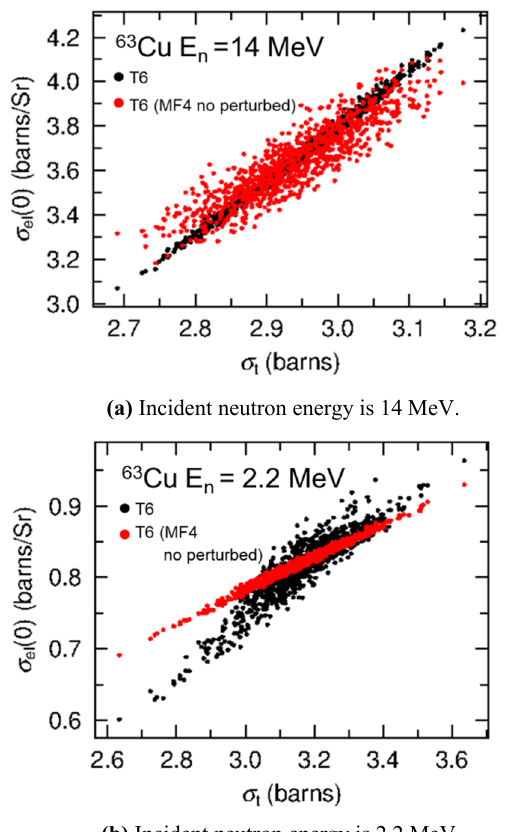
Fig. 11. Correlation between 63 Cu total cross section and elastic scattering cross section at 0 degree of 1,000 random files generated by